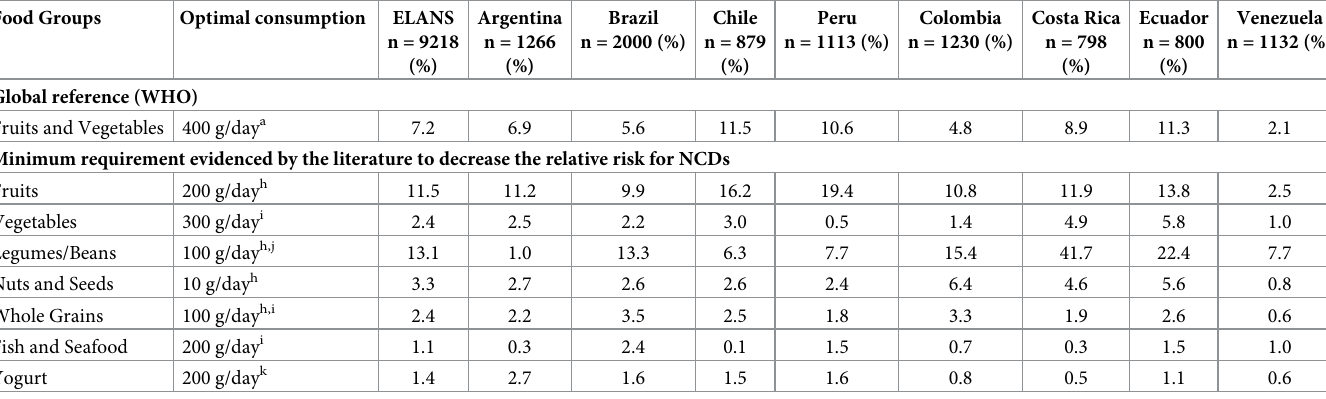
Table 4. Prevalence of optimal consumption of the ten major foods groups in individuals residing in urban areas of eight Latin American countries. Food